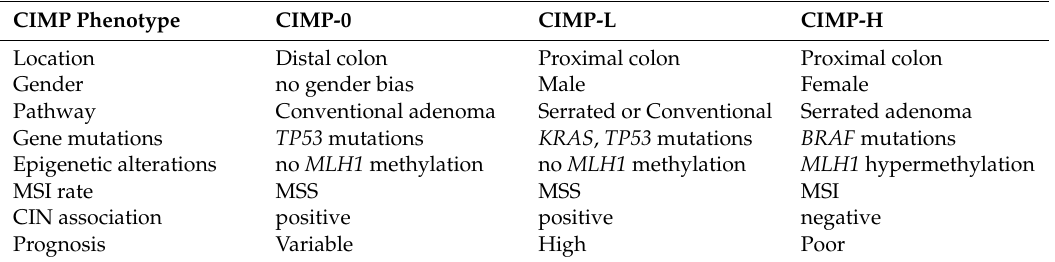
Table 2. Characteristics of CpG island methylator phenotype (CIMP) subtypes bearing serrated colorectal